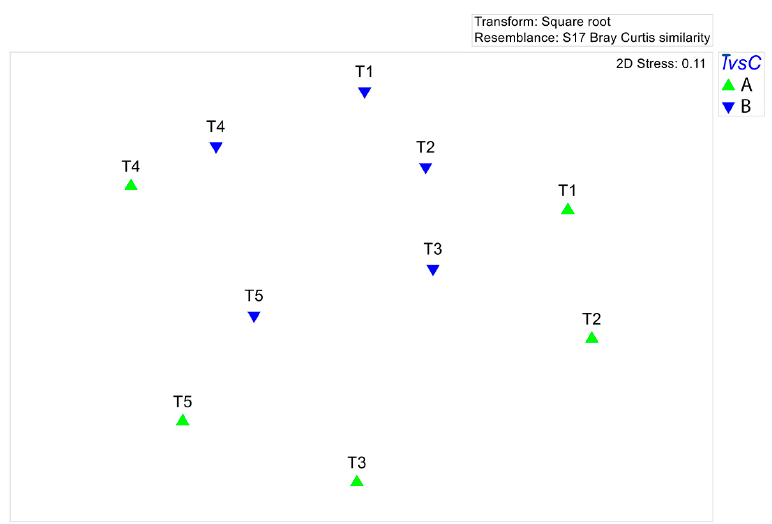
Figure 6. Non-metric multidimensional scaling (nMDS) plot on the macrobenthic assemblages at two Times Before (T1, T2) and three Times After (T3–T5) the bioremediating action, respectively at the Treatment ( A ) and the Control ( B ) sites.